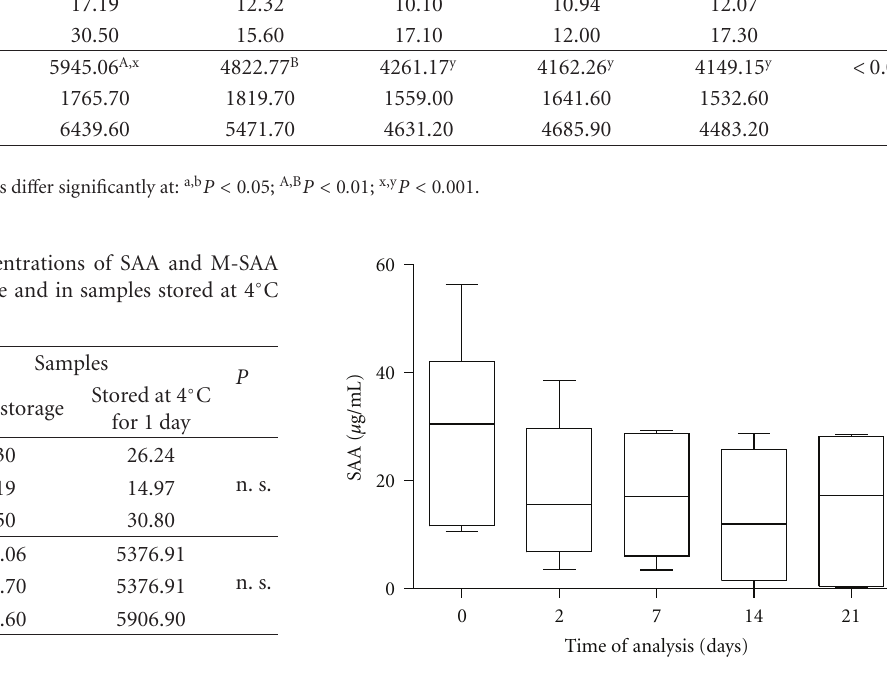
Figure 1: Concentrations of SAA in serum samples during freezer storage. The plots show the median (line within box), 25th and 75th percentiles (box), and minimum and maximum values (whiskers).